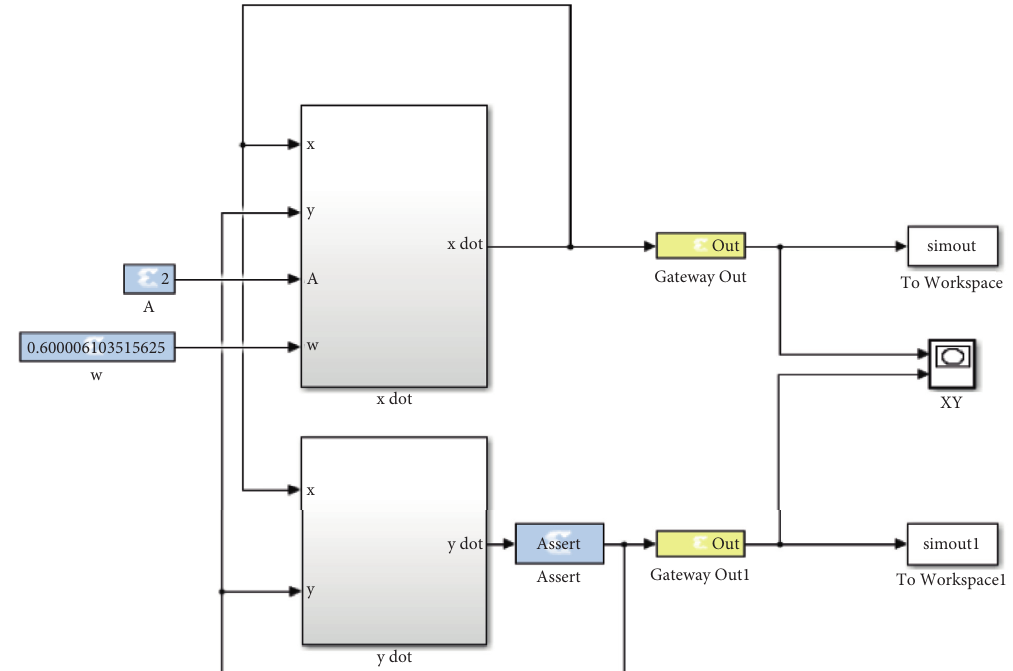
Figure 6: Xilinx system generator (XSG) Simulink diagram of System (2) with ω � 0 . 6 and amplitude A � 2. It is another representation of the proposed system in nonautonomous